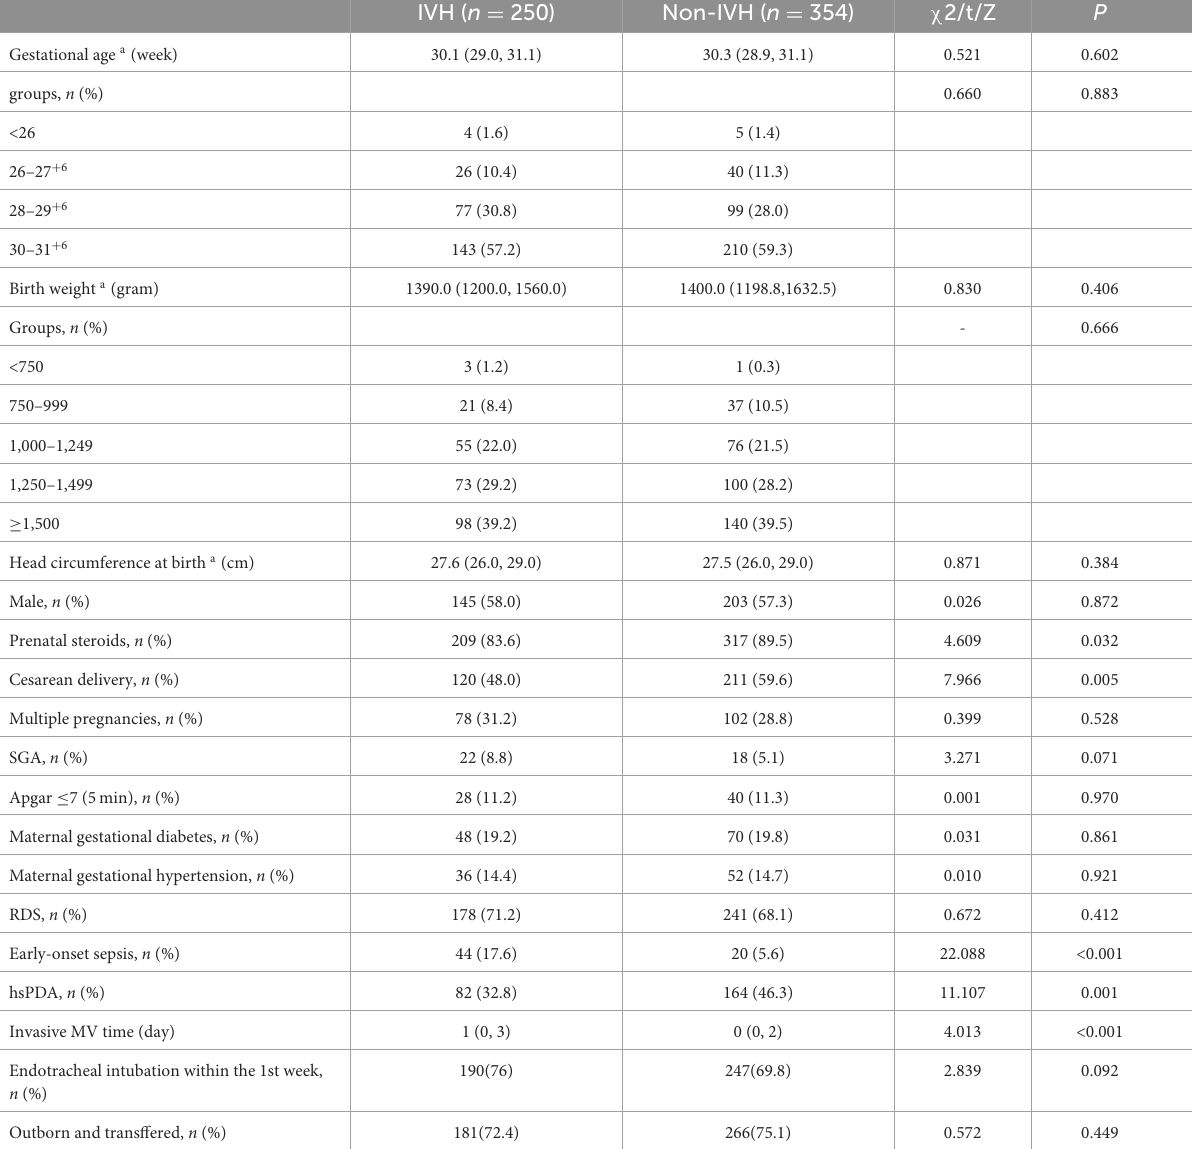
TABLE 2 Perinatal characteristics of VPIs in the two